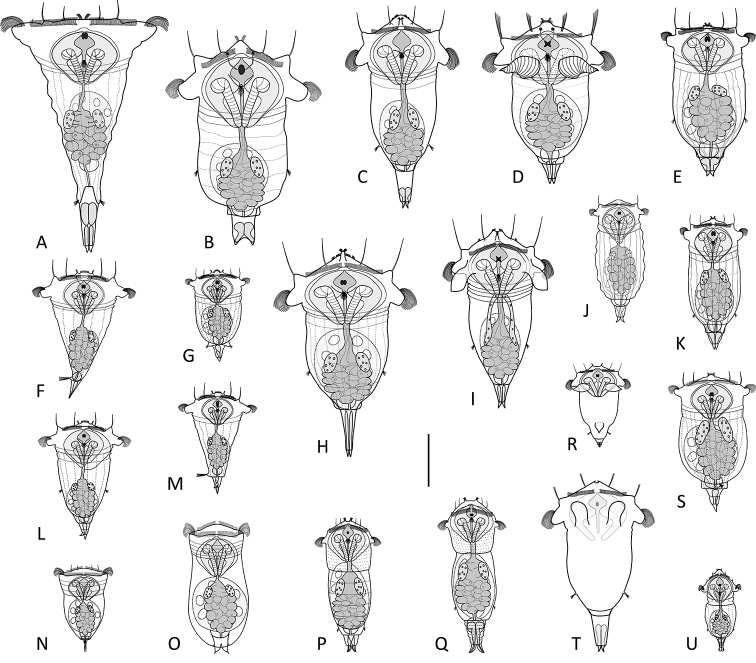
Species of Synchaeta from brackish, marine and inland saline habitats. AS.
grimpeiBS.
balticaCS.
johanseniDS.
bicornisES.
gyrinaFS.
triophthalmaGS.
ceciliaHS.
voraxIS.
fennicaJS.
cylindricaKS.
tavinaLS.
neapolitanaMS.
hutchingsiNS.
atlanticaOS.
rousseletiPS.
glacialisQS.
hyperboreaRS.
arciferaSS.
tamaraTS.
bacilliferaUS.
squamadigitata. Drawings modified from: CHarring (1921)DKoste (1981)G, K, LRousselet (1902)IRousselet (1909)JAlthaus (1957)NZelinka (1907)OZelinka (1927)P, Q, SSmirnov (1932) and Friedrich and De Smet (2000)RRougier and Pourriot (2006)TSmirnov (1933)UDe Smet (2006). Scale bar: 100 µm.